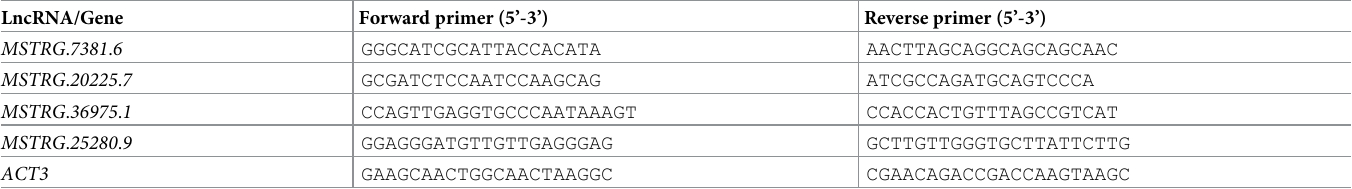
Table 1. The gene, lncRNA and primers used for qRT-PCR